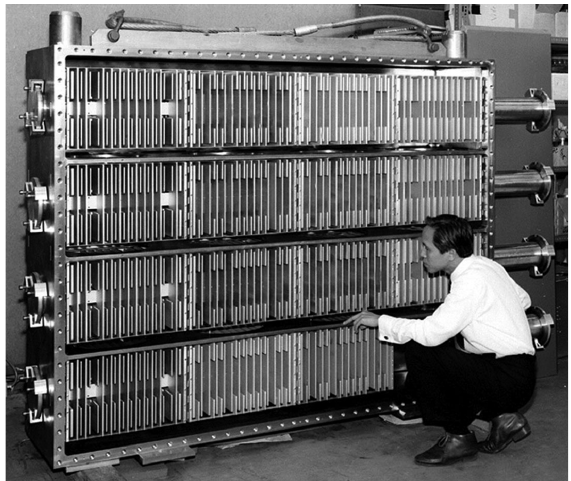
FIG. 16. Side view of sixteen KFA14 kicker magnets in a vacuum tank. There are four rows of kicker magnets, each row containing four kicker magnets. Each row corresponds to one of the four PSB rings. The interleaved ground and the high voltage (HV) plates of each of the transmission line type kicker magnets are